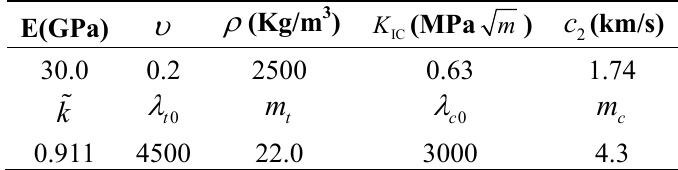
Table 1. Material parameters of concrete under dynamic compression and tension.